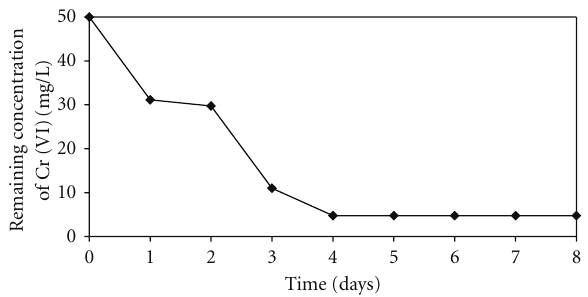
Figure 7: Removal of Chromium (VI) in industrial wastes incu- bated with the fungal biomass. 100 rpm, 28 ◦ C, pH 4.0, 50 g of contaminated soil (50mgCr(VI)/g